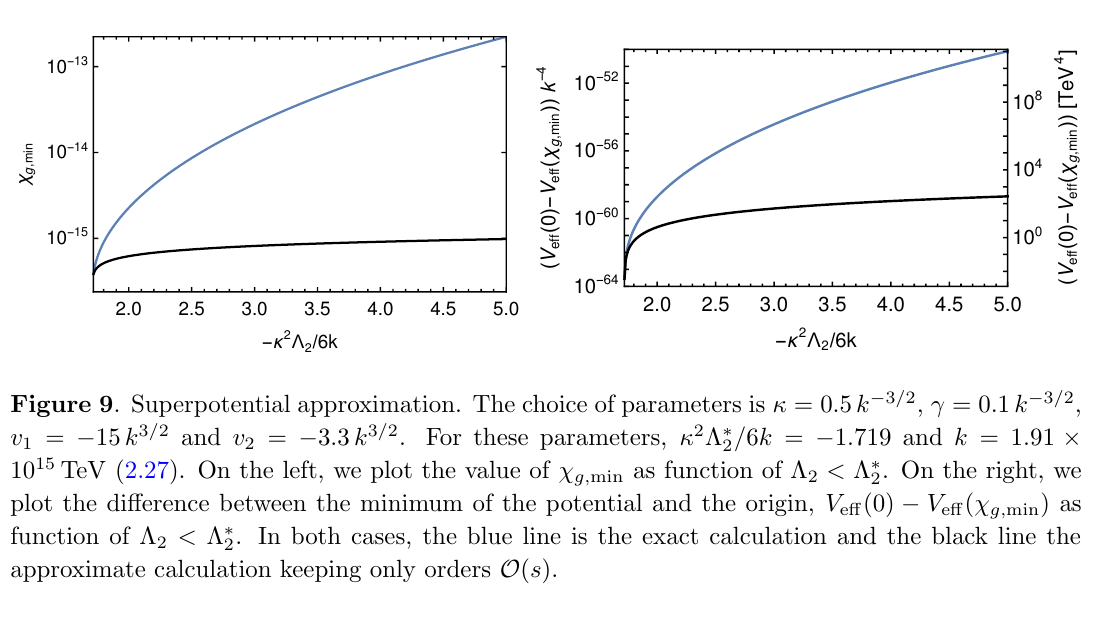
Figure 8 . Exact and approximate e(cid:11)ective potential normalized to V e(cid:11) (0) = 0. The (cid:12)xed param- eters are (cid:20) = 0 : 5 k (cid:0) 3 = 2 , (cid:13) = 0 : 1 k (cid:0) 3 = 2 , v 1 = (cid:0) 15 k 3 = 2 , v 2 = (cid:0) 3 : 3 k 3 = 2 , and (cid:20) 2 (cid:3) 2 = 6 k = (cid:0) 1 : 8. For these parameters, (cid:20) 2 (cid:3) (cid:3) = 6 k = (cid:0) 1 : 719 and k = 1 : 91 (cid:2) 10 15 TeV (2.27). The left vertical axis is given 2 in units of k 4 and the right one, in TeV 4 . The blue line is the exact calculation of V e(cid:11) . The black, red and green lines are the approximation up to the (cid:12)rst, second and third order respectively. The vertical dashed line is the value (cid:31) g; 0 = 3 : 8 (cid:2) 10 (cid:0) 16 where the approximation is exact.